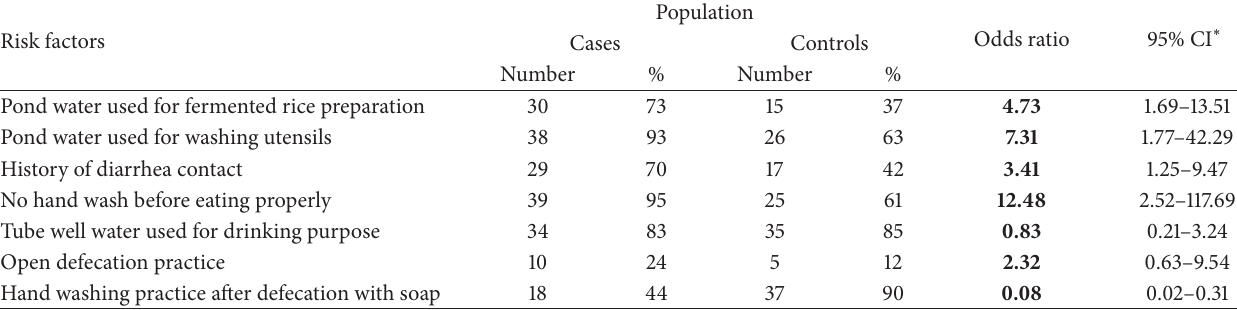
Table 2: Selected risk factors of the cholera outbreak at Haibatpur village, Purba Medinipur district, West Bengal, India, 2012. Risk